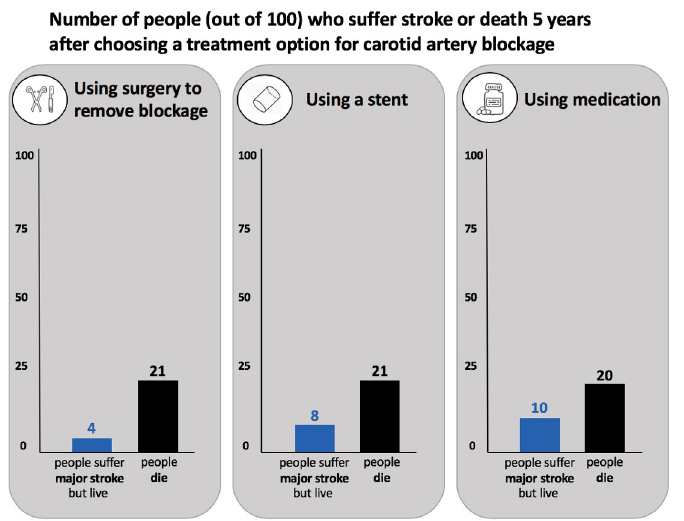
Fig 3. Bar graph presented in the